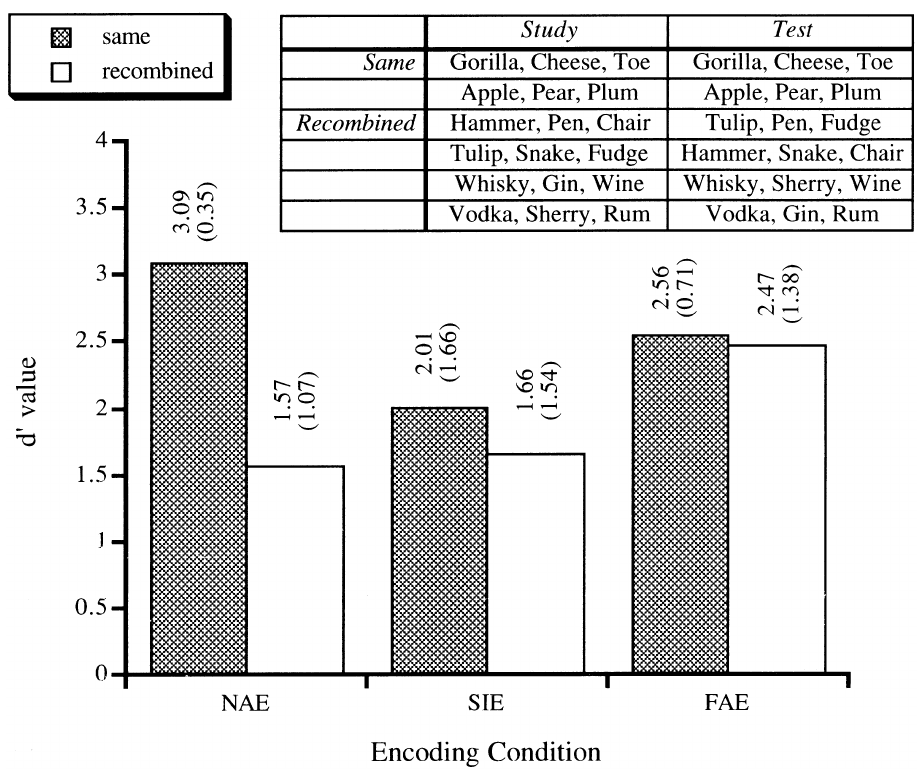
Fig. 1. Mean recognition performance for the six subjects included in the analysis expressed as mean d’ is shown for same and recombined triplets in each of the three encoding conditions. The false alarm rate for the d’ calculations was based on the proportion of incorrect selections of the completely novel word triplets. A d’ value for associative recognition was calculated by subtracting the d’ values for the recombined triplets from studied triplets for each of the three encoding conditions (d’ NAE = 1 . 52 [ s . d . = 0 . 86 ] ; d’ SIE = 0 . 35 [ s . d . = 0 . 58 ] ; d’ FAE = 0 . 09 [ s . d . = 1 . 22 ] . An ANOVA where type of association was a within subjects factor (novel, familiar, single) with linear contrast effects indicated that the difference scores were greater for the NAE condition than the other two ( F ( 1 , 10 ) = 6 . 00, p < 0 . 05), but did not differ between FAE and SIE conditions. In fact, associative recognition in these two latter conditions was not above chance levels ( F ( 1 , 5 ) = 0 . 031, p = 0 . 87 and F ( 1 , 5 ) = 2 . 175, p = 0 . 2 respectively). An approximate estimate of non-associative word recognition is provided by the d’ score for the recombined